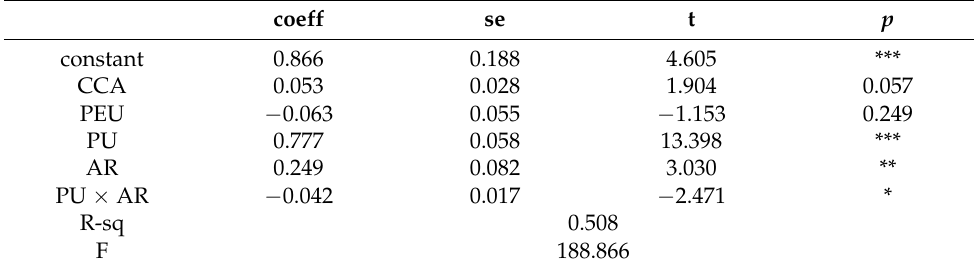
Table 10. Test of moderating